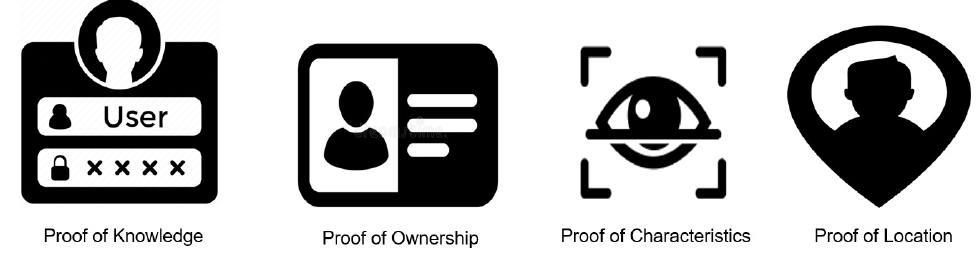
Figure 1. Fundamental Authentication